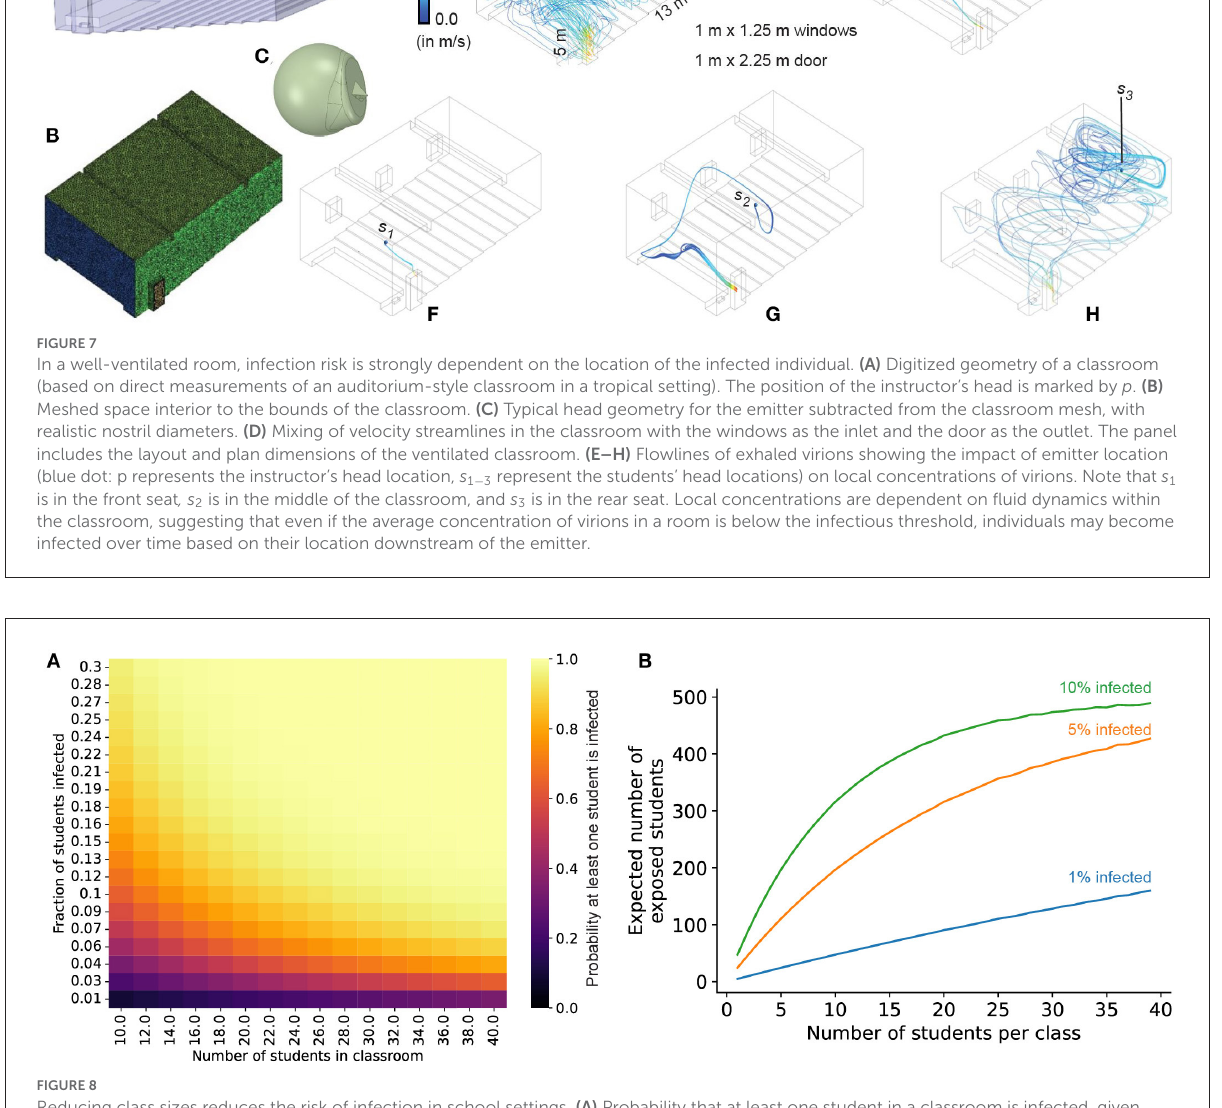
(blue curve: 1% of students infected, orange curve: 5% infected, green curve: 10%